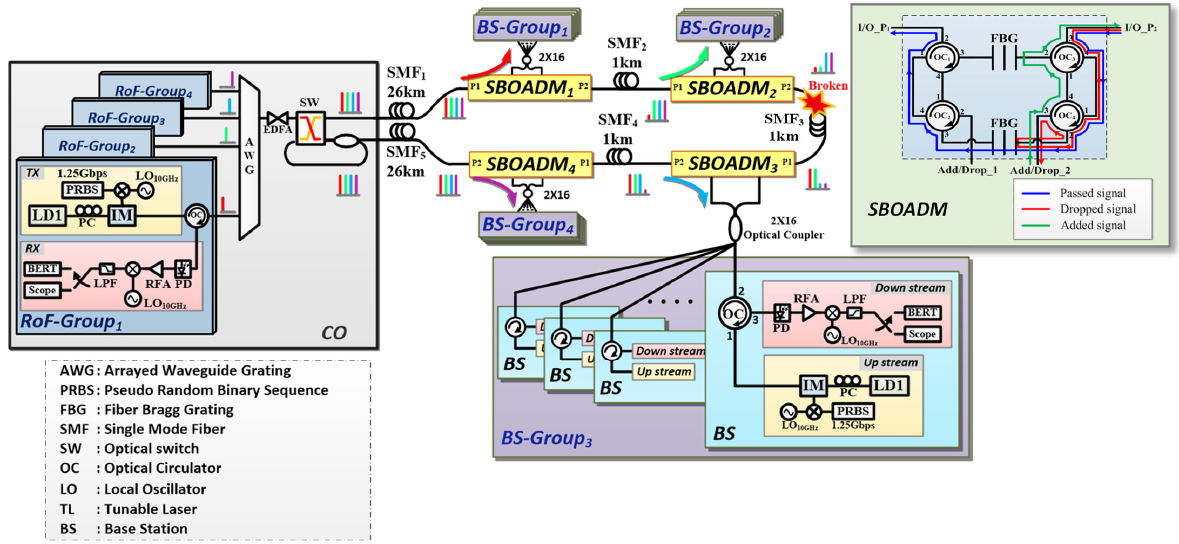
Figure 8. Diagram of the routing of downlink optical signal in the hybrid ring- and tree-topology RoF transmission system when breakpoints occur.